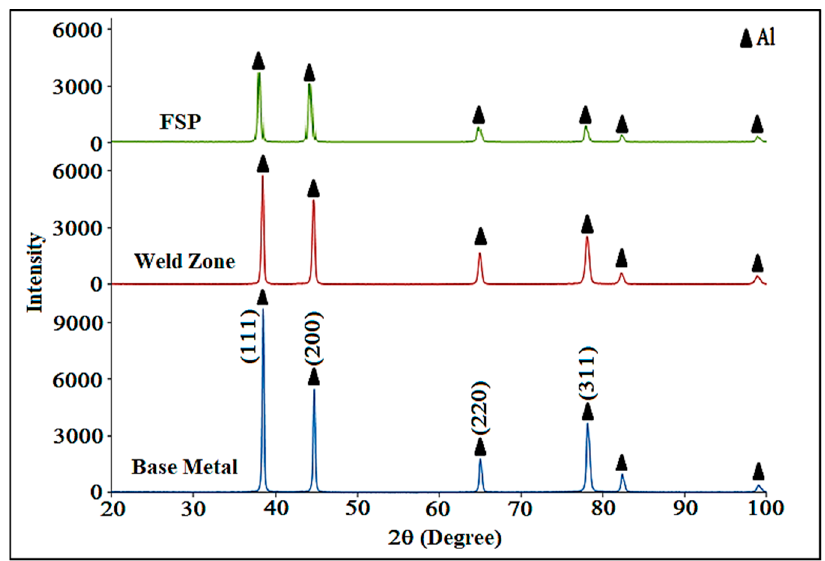
Figure 8. ( a ) Optical micrograph of grain boundaries image of FSP specimen, ( b ) EBSD orientation map (white colour for LAGBs and black colour for HAGBs).